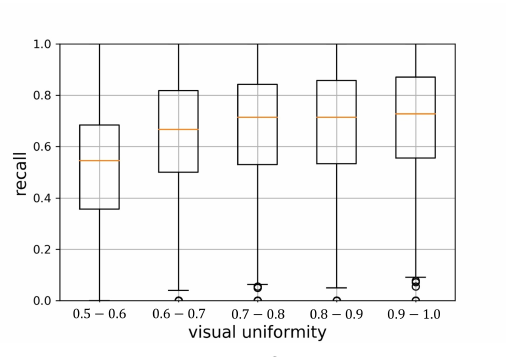
Figure 17. Relations between visual uniformity C p